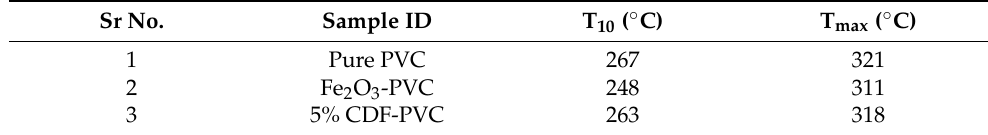
Table 4. T 10 and T max of the synthesized PVC